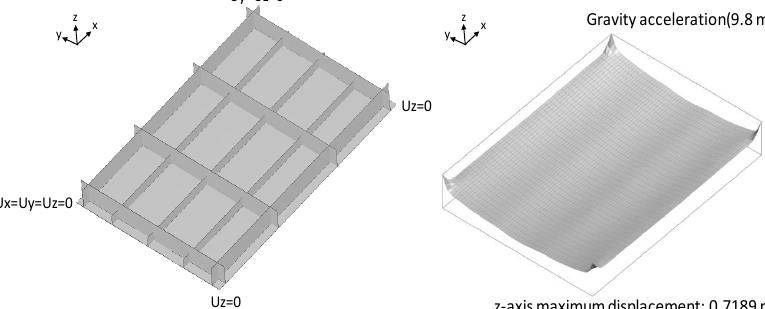
Figure 7. E ff ect of gravity force on the bottom plate under the simple boundary condition. Figure 7. Effect of gravity force on the bottom plate under the simple boundary condition.